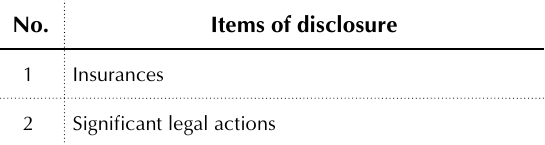
Table 5. Damage risks